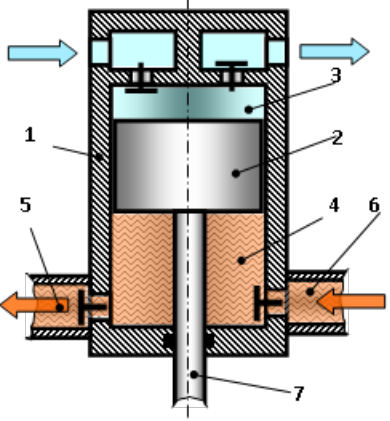
Figure 1. Construction diagram of PHPM (1 — cylinder; 2 — piston; 3, 4 — compressor and pump cavity; 5, 6 — discharge and suction liquid nozzles; 7 — plunger).